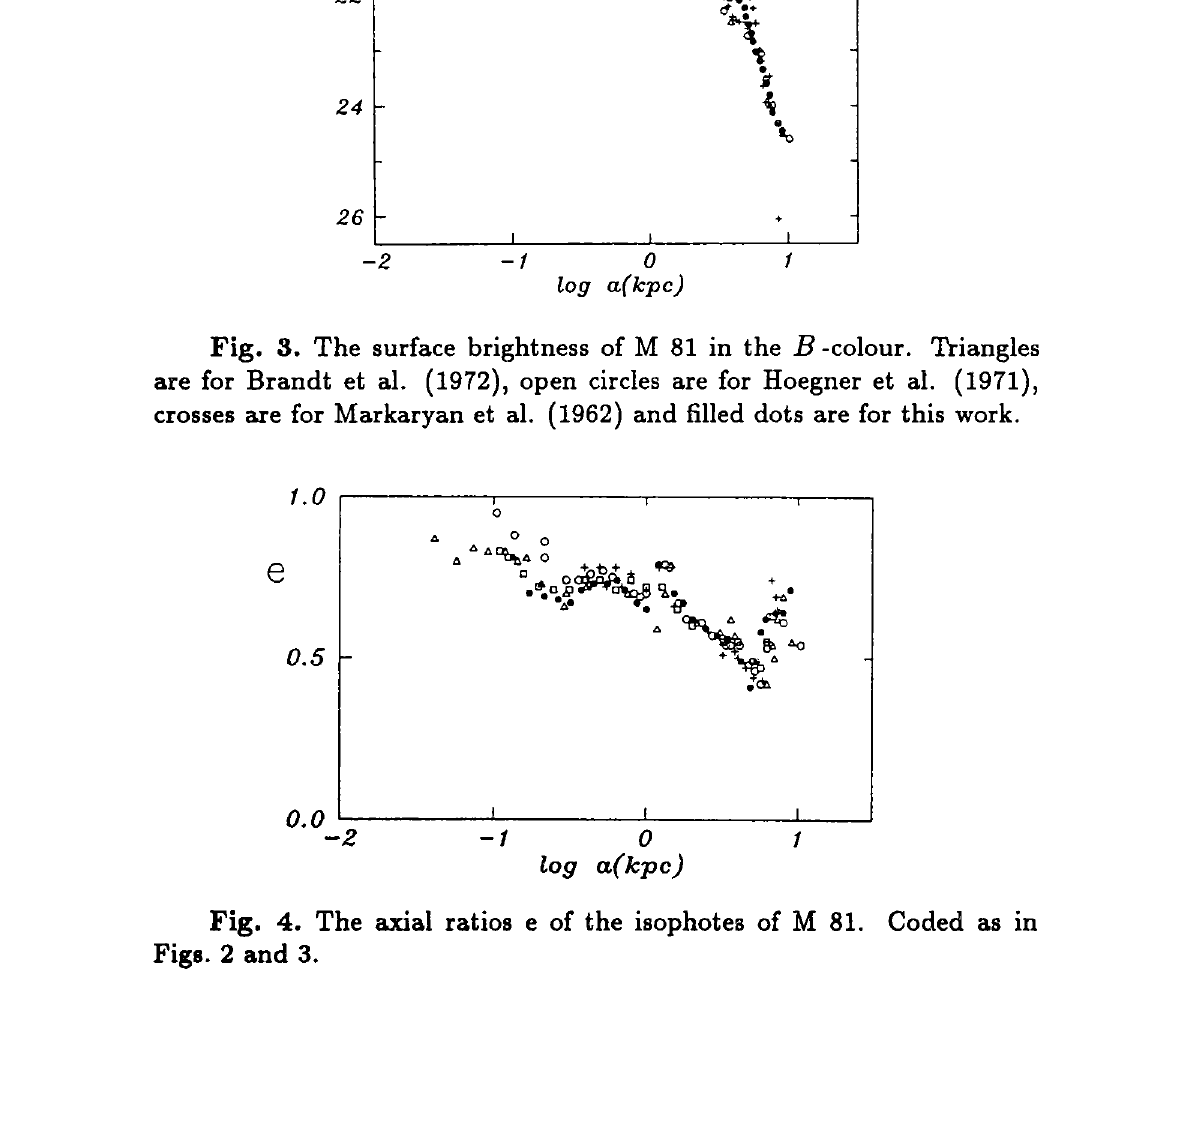
Fig. 4. The axial ratios e of the isophotes of M 81. Coded as in Figs. 2 and